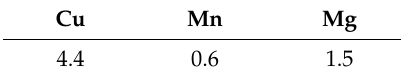
Table 2. Aluminum alloy 2024 nominal composition (wt.